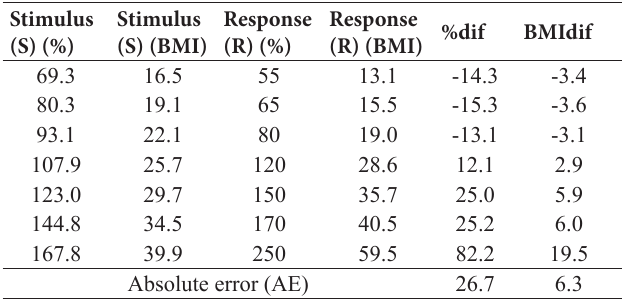
and BMI dif dif